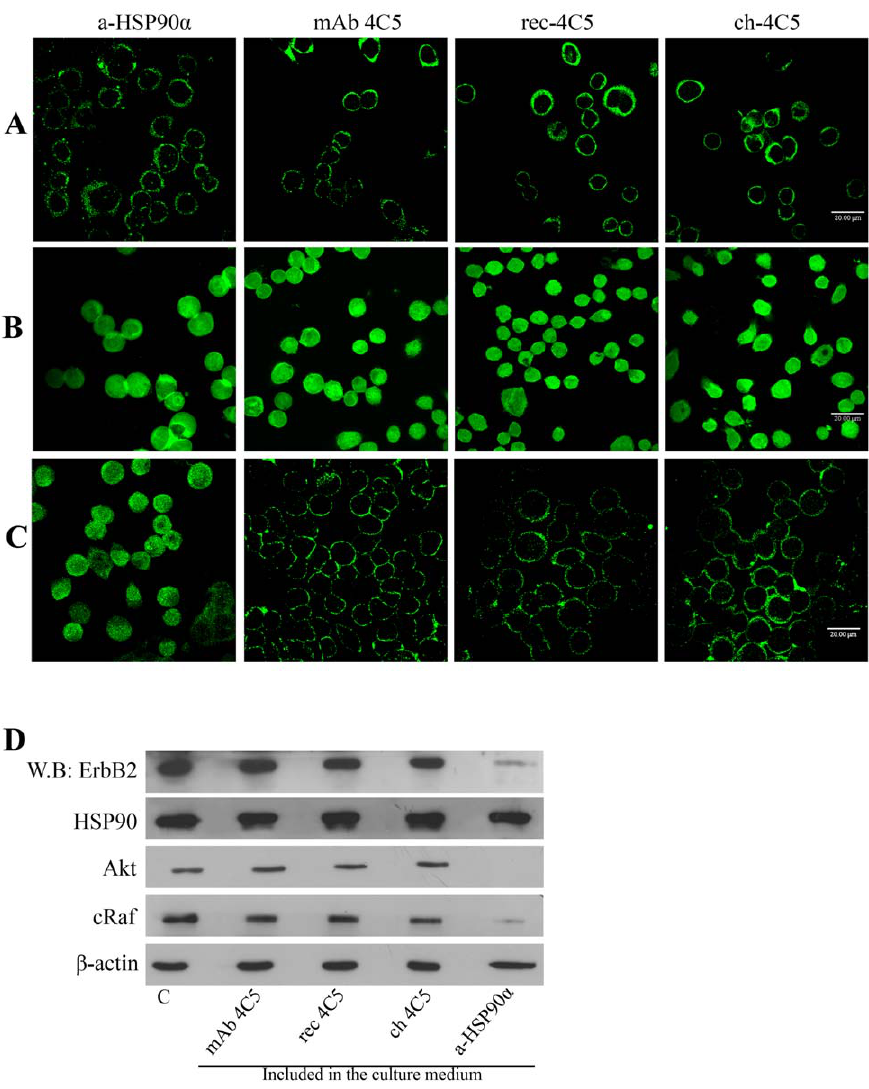
Figure 4. ch-4C5 binds to the surface pool of HSP90 and is not internalized by MDA-MB-453 cells. A . Immunofluoresence labelling of MDA-MB-453 cells using both the rec-4C5 and ch-4C5. The punctuate immunolabeling indicates the surface pool of HSP90. Negative controls were performed using an antibody against the intracellular protein b tubulin (data non shown). Scale bar: 20 m m B . Immunofluoresence detection of intracellular HSP90 in fixed MDA-MB-453 cells, permeabilized with 0.1% Triton X-100. Similarly to the murine antibody, rec-4C5 and ch-4C5 recognize the intracellular pool of HSP90. Scale bar: 20 m m C . For detection of antibody internalization, live cells were incubated with the antibodies for various time intervals, then fixed, permeabilized and fluorescently labelled. No internalization of mAb4C5, rec-4C5 and ch-4C5 is observed even after 24 h of incubation. In contrast the anti-HSP90 a antibody could be detected intracellularly after 24 h of incubation. Scale bar: 20 m m D . MDA-MB-453 cell lysates, treated with mAb 4C5, rec-4C5, ch-4C5 and anti-HSP90 a were analyzed by western blot using antibodies against ErbB2, Akt, cRaf and HSP90 a . Actin served as a loading control. Presence of mAb 4C5, rec-4C5 and ch-4C5 did not affect the levels of the kinases compared to controls. In contrast the cell permeable anti-HSP90 a antibody significantly reduced the levels of ErbB2, Akt and